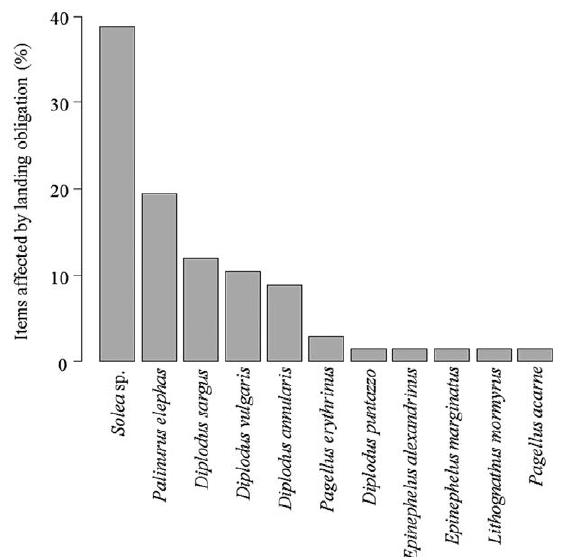
Fig. 5. – Percentage of abundance of the 67 discarded captures af- fected by the landing obligation (Article 15 of EU Reg. 1380/2013) in the 1005 netting wall surveyed in this